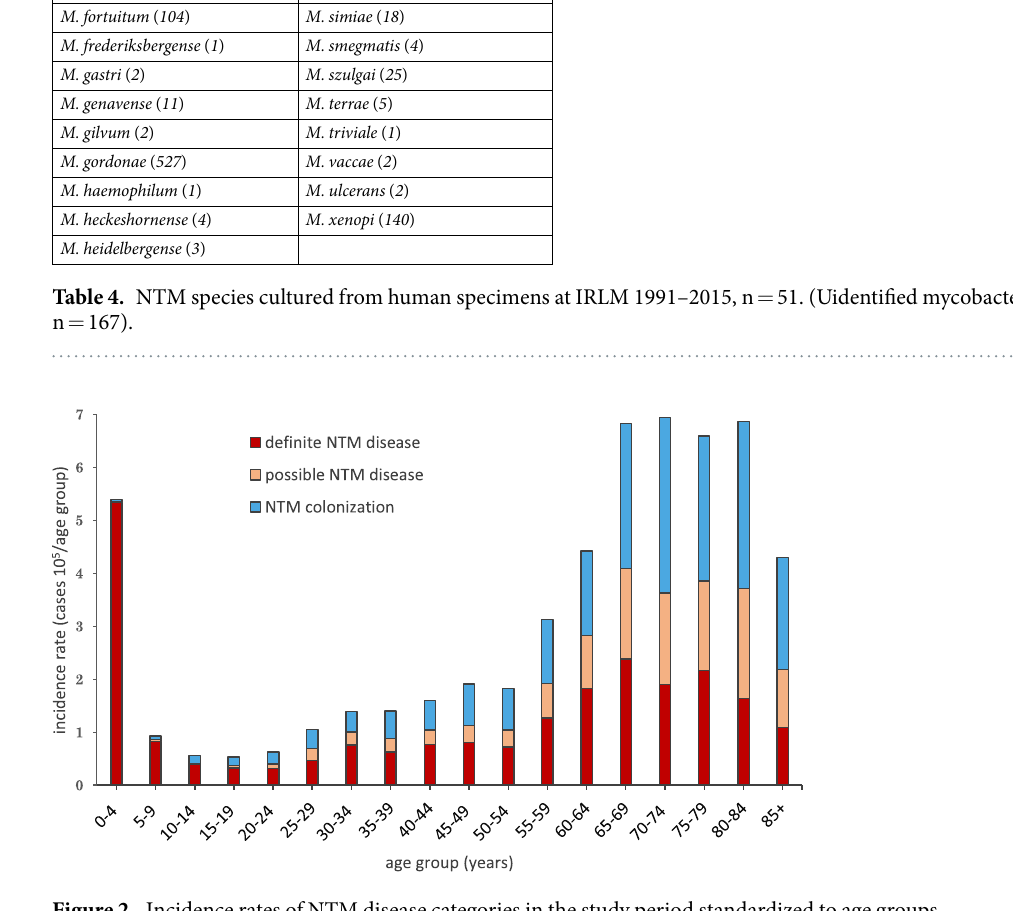
M. marinum originated from an extra-pulmonary site in the vast majority of cases (98%). Among these, the clinical specimen was a skin or wound biopsy in 90%, while the remaining sites were from a bone or joint biopsy. These findings confirm the presence of M. marinum as a pathogen prone to cause cutaneous infections 28 . Elderly from age 65 had a relative risk of a positive NTM culture more than ten times that of adolescents aged 15–19 when we calculated age-standardized incidence rates. This association between old age and an increased incidence of NTM disease is well known and has been associated with comorbidities in the ageing population 29 . In addition, we found the median age of patients with a positive NTM culture to increase during the last 25 years. Initially, we hypothesized that increased longevity in the population was partly responsible for the expected